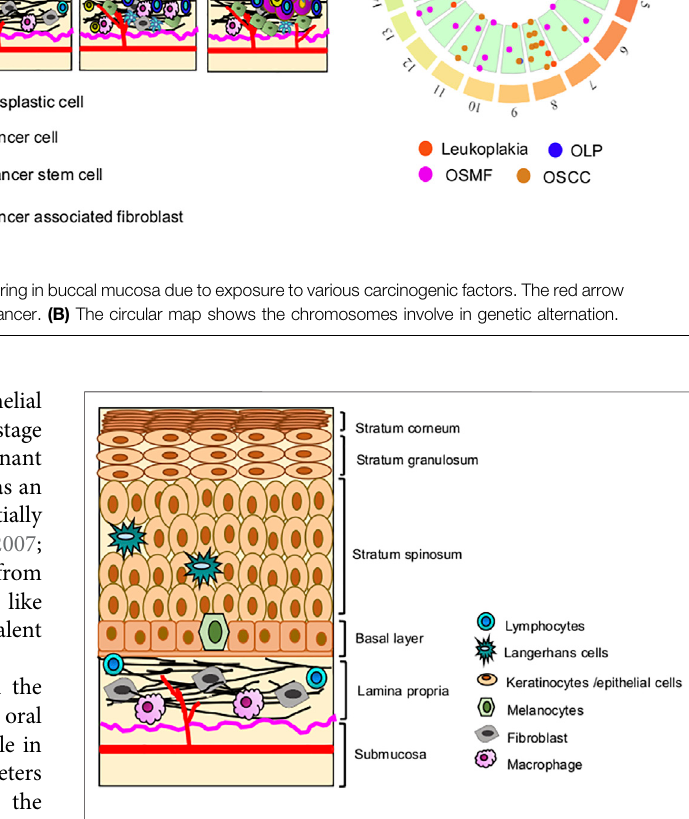
FIGURE 1 | Systematic representation of normal buccal